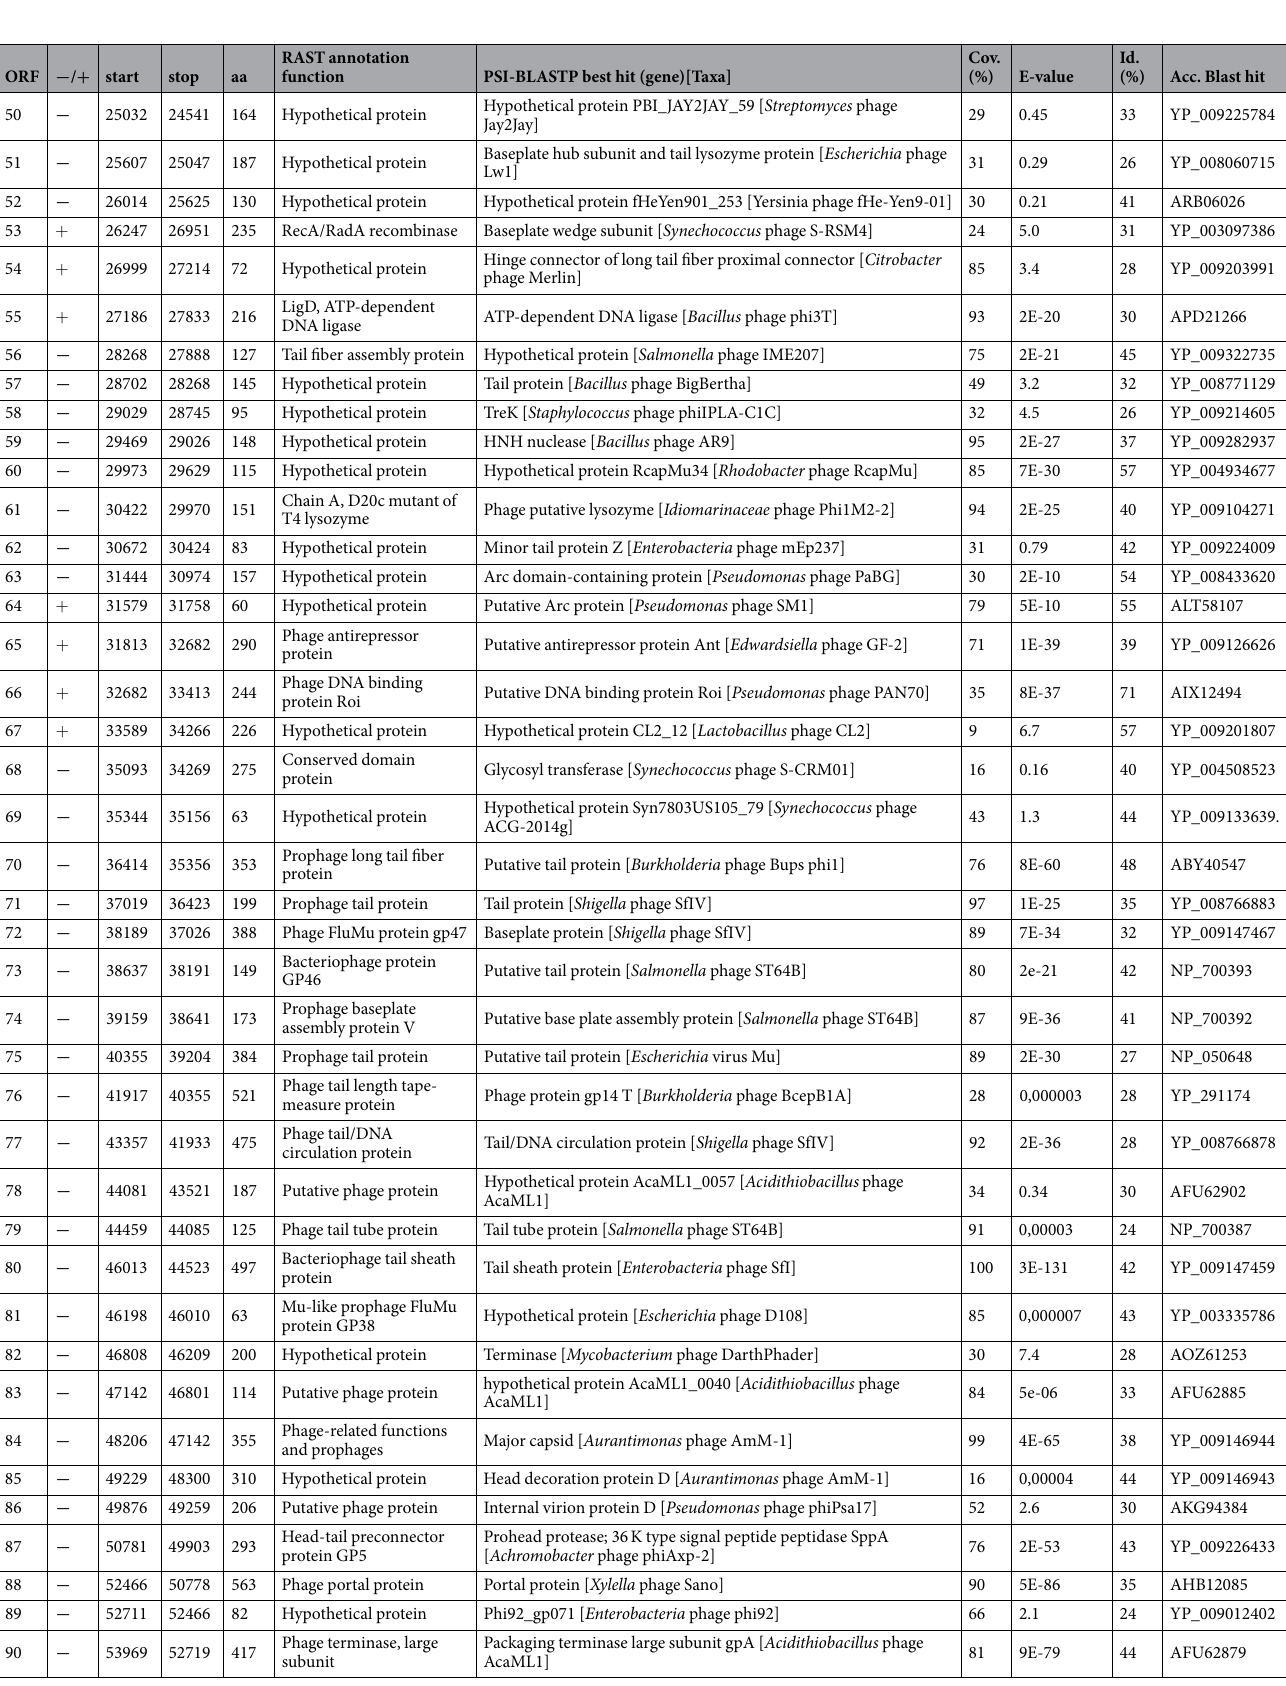
Table 1. Genome ɸ 437